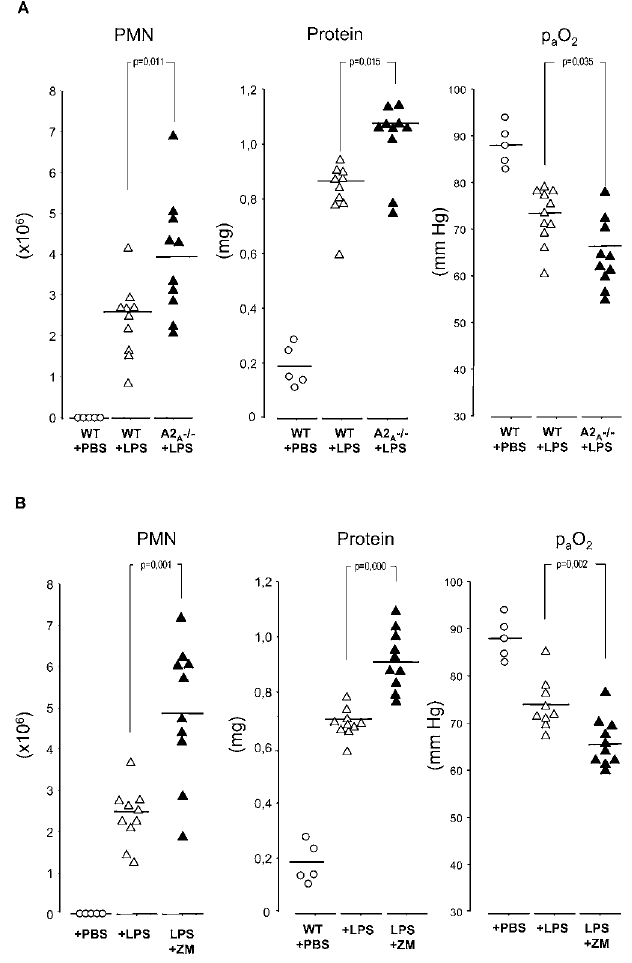
Figure 5. Evidence for the Critical Role of Immunosuppressive A 2A R in Lung Protection from Inflammatory Damage (A) In A 2A R gene-deficient mice, number of PMNs (left graph) and amount of protein recovered (center graph) 48 h after IT LPS injection by BAL was significantly higher than in similarly treated wild-type control mice, reflecting increased lung damage in the absence of A 2A R. The arterial oxygen tension (right graph) was lower in A 2A R gene-deficient mice as compared with wild-type mice. (B) Pharmacologic inactivation of A 2A R leads to exacerbated inflammatory lung tissue damage and decreased lung funciton. After estimation of biologically relevant half-life of A 2A R antagonist ZM241385 (ZM) in vivo (unpublished data), the IT LPS-injected mice were administered ZM241385 at a dose of 10 mg/kg body weight every 6 h subcutaneously to ensure sufficient levels of the antagonist. This dosing regimen of the A 2A R antagonist caused significant more lung tissue damage, as reflected by increased number of PMNs (left graph) and protein levels (center graph) in the BAL fluid obtained after 48 h. In parallel experiments, the A 2A R antagonist decreased lung function (right graph) as compared to untreated wild-type mice, in agreement with results of experiments with A 2A R gene-deficient